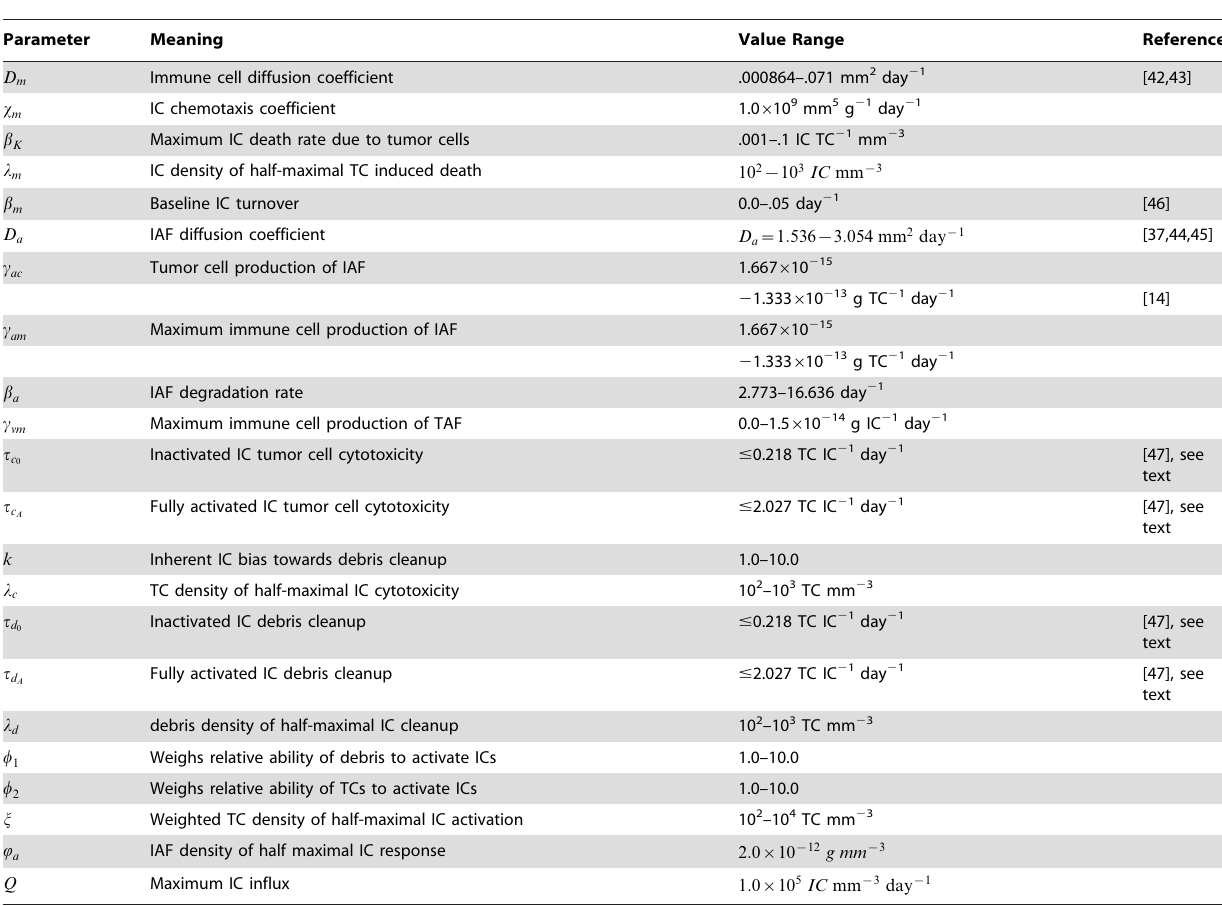
Table 2. All immune extension parameters and